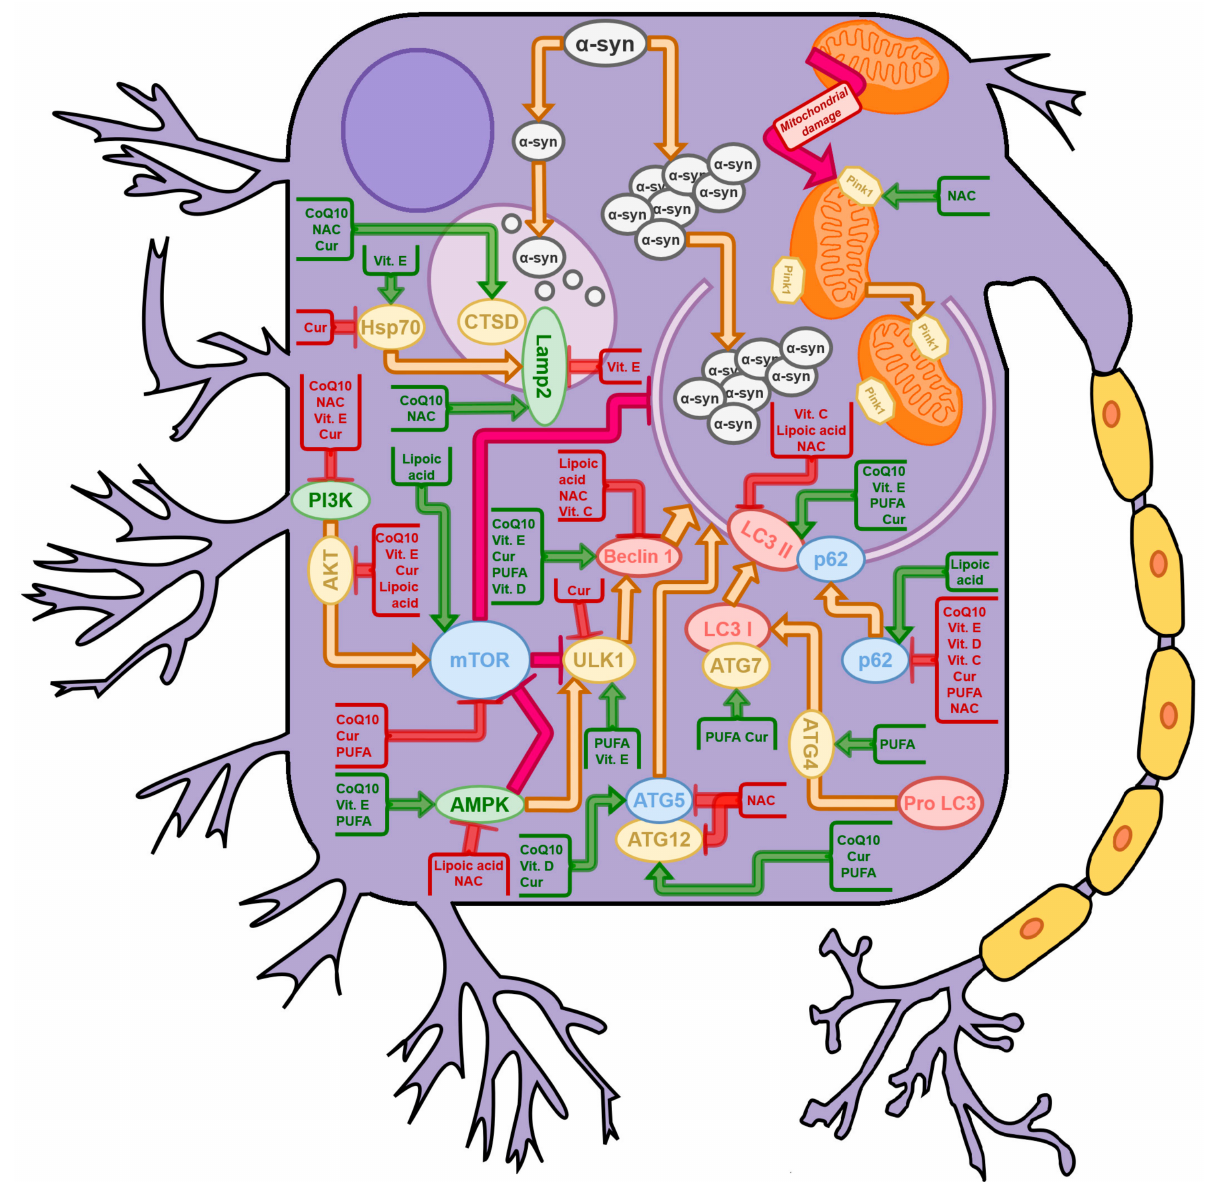
Figure 2. Diagram presenting the modulation of the autophagy pathway in mammalian nerve cells in- duced by compounds described in this review. The green arrows indicate induction of mRNA/protein expression, whereas the red arrows indicate an inhibitory effect of the presented